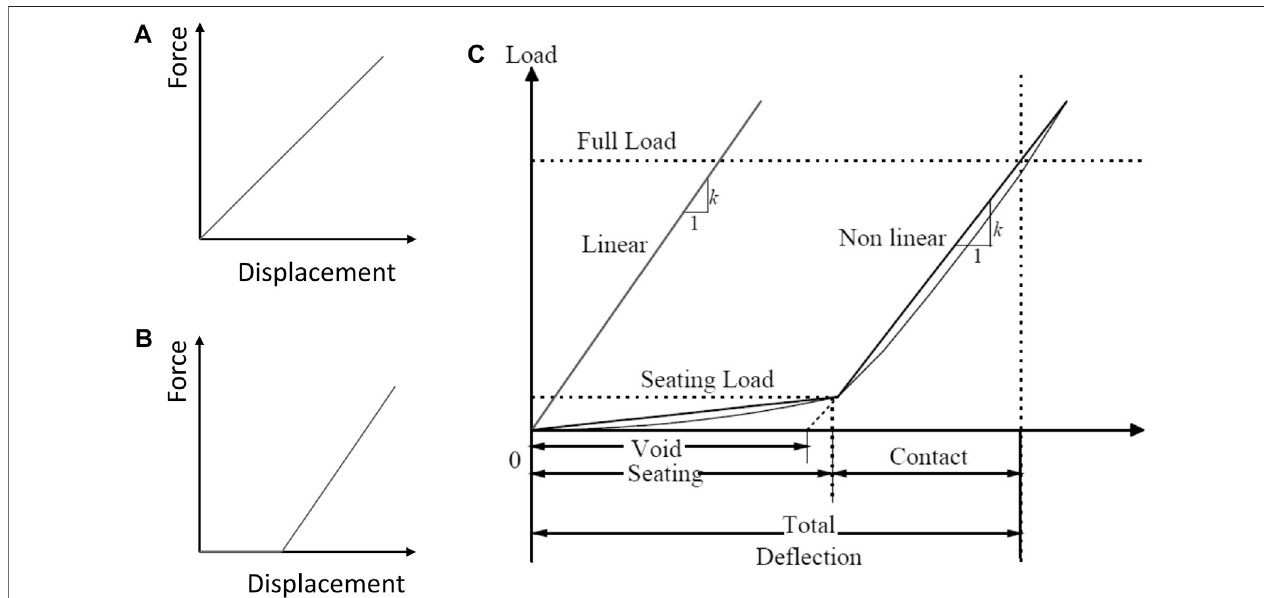
FIGURE 3 | Schematic of force displacement behavior at the tie-ballast interfae: (A) No gap; (B) In the pressence of a gap; (C) Theoretical representation of the behavior (reproduced from Sussmann et al., 2001).